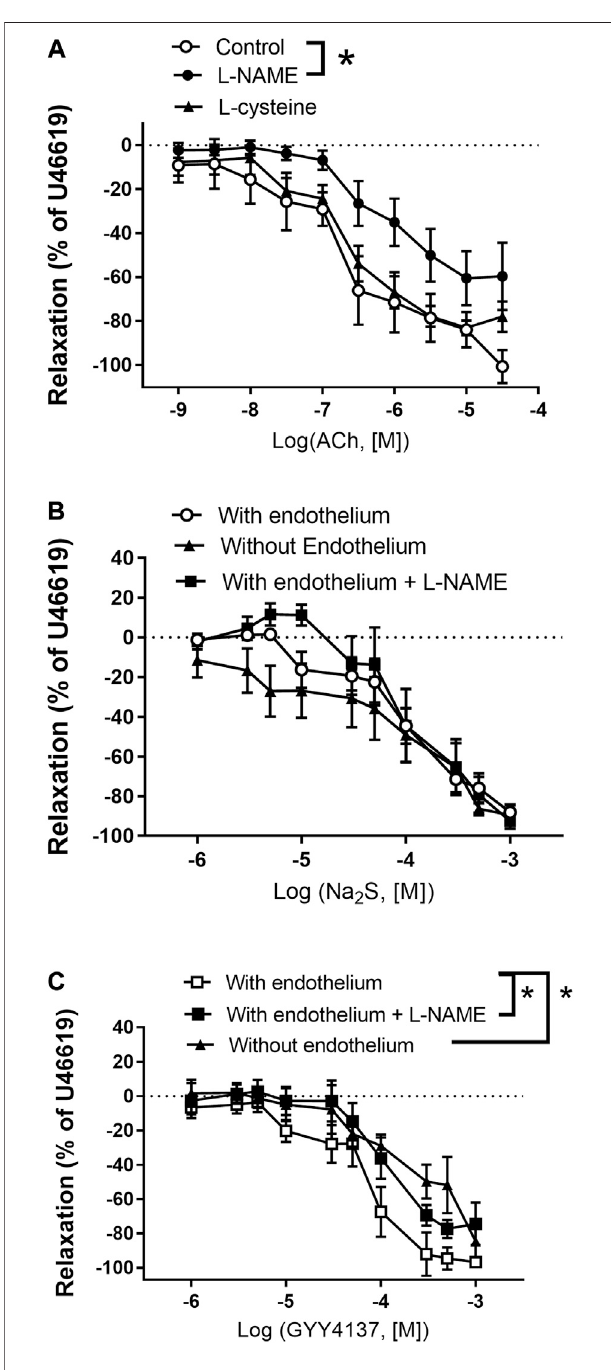
FIGURE 5 | Role of the endothelium and NO for Na 2 S and GYY4137 relaxation (A) Average relaxations induced by acetylcholine (ACh) in the absence ( n (cid:2) 7) and the presence of either L-NAME (100 µM) ( n (cid:2) 6) or L-cysteine (1 mM) ( n (cid:2) 7) in rat mesenteric arteries (B) Na 2 S induced vascular relaxation in vessels with ( n (cid:2) 11) and without endothelium ( n (cid:2) 5), or with endothelium in the presence of an NO synthase inhibitor, L-NAME ( n (cid:2) 6) (C) GYY4137 induced vascular relaxation in vessels with ( n (cid:2) 12) and without endothelium ( n (cid:2) 6) or with endothelium in the presence L-NAME ( n (cid:2) 6). Where no error bars are indicated, error lies within dimensions of symbol. All data are means ± SEM. * p < 0.05, two-way ANOVA.